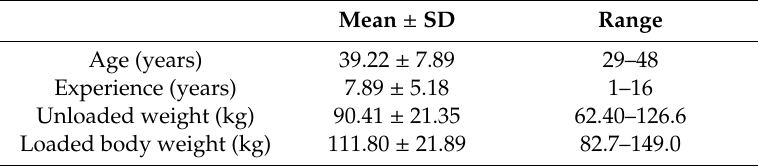
Table 1. Descriptive characteristics of firefighter participants (n =